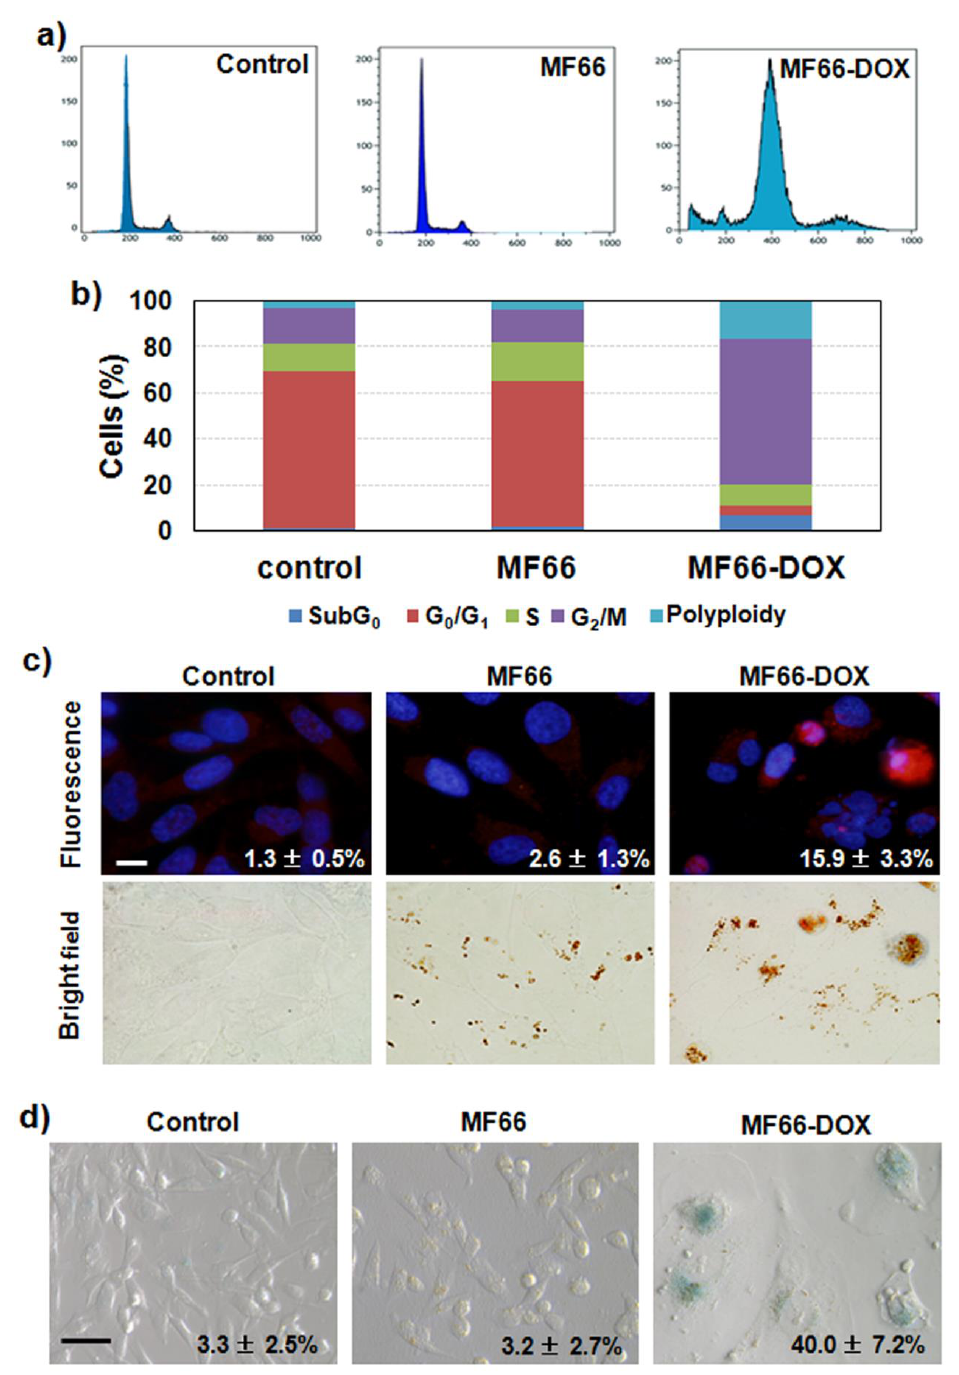
Figure 3. Cellular inactivation mechanisms analysed after incubation of MDA-MB-231 cells with electrostatic formulation. ( a ) Representative cell cycle histograms 72 h after 24 h of incubation with the di ff erent formulations. ( b ) Bar chart displaying percentages of cells in the di ff erent phases of cell cycle 72 h after 24 h treatments. ( c ) Apoptotic cells visualized by indirect immunofluorescence for cleaved caspase 3 (red) and DNA staining (blue) analysed 72 h after 24 h treatment. Scale bar: 10 µ m. Percentages included are the apoptotic cells over the total number of cells. ( d ) Senescent cells analysed by senescence-associated β -galactosidase activity (blue) 96 h after treatment incubated for 24 h visualized in di ff erential interference contrast (DIC) microscopy. Scale bar: 50 µ m. Percentages included are the senescent cells over the total number of